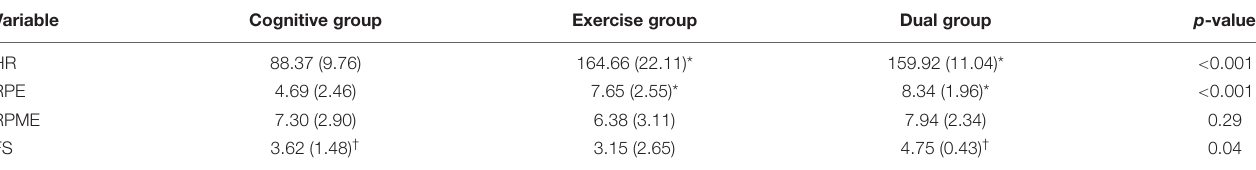
TABLE 2 | Manipulation checks by condition.